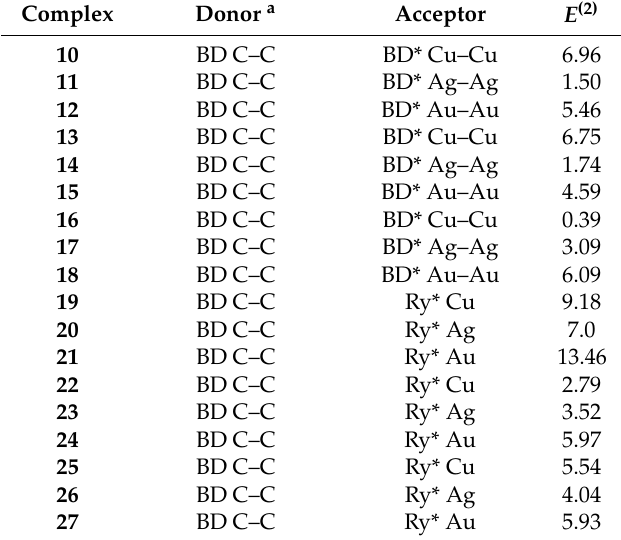
Table 2. Donor and acceptor NBOs with indication of the second-order interaction energy E (2) (kcal · mol − 1 ) for complexes 10 – 27